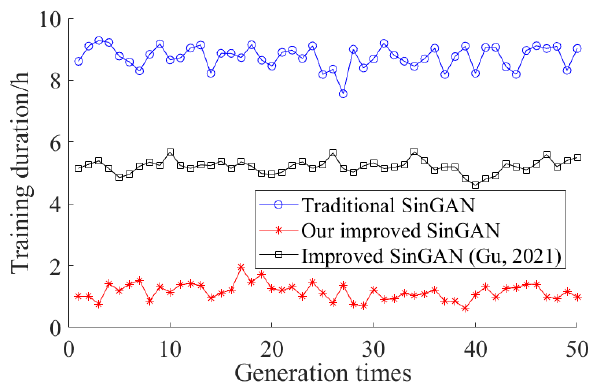
Figure 11. Training duration of different SinGAN models [25].